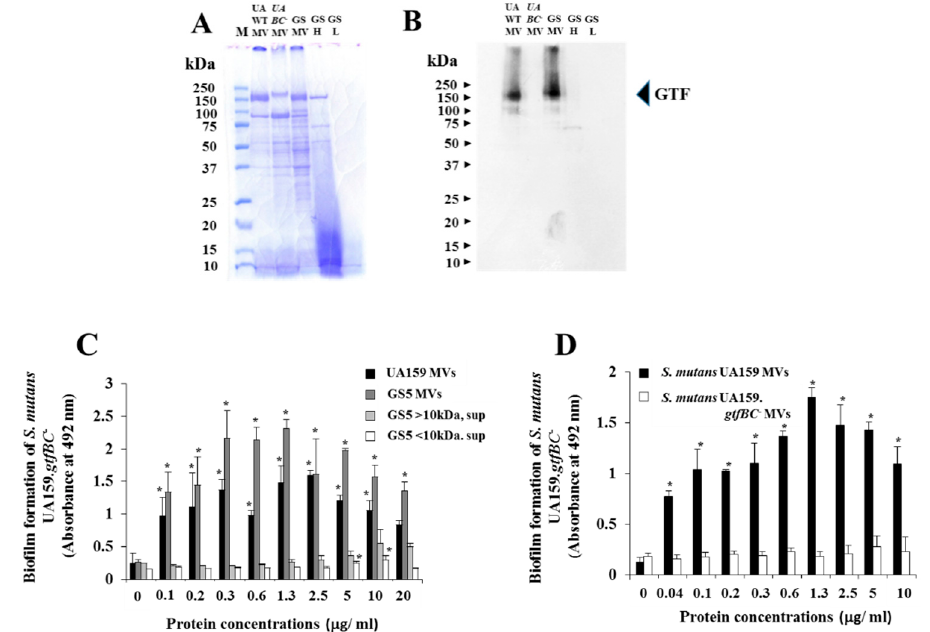
Figure 6. Biofilm formation of S. mutans by MVs. ( A ) MVs from S. mutans UA159